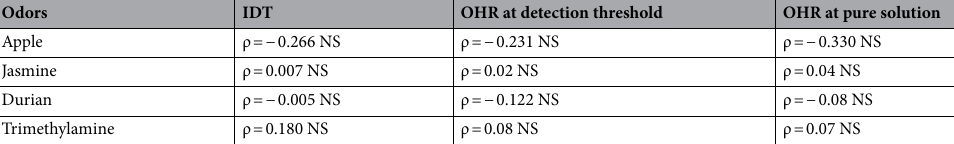
Table 8. Spearman rank correlations between hunger level and IDT, OHR at detection threshold/at pure solution in each odor session. Non-significant results are noted as NS.